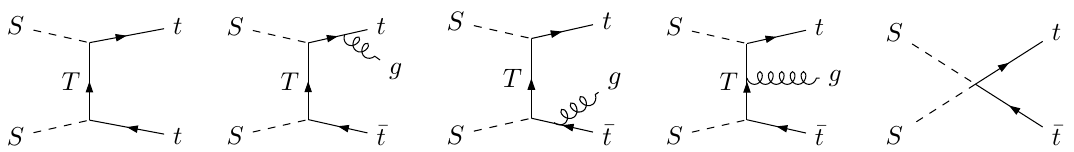
Figure 1 . Representative Feynman diagrams of processes which contribute to the annihilation cross section of top-philic DM. Illustrative LO (left-most), QCD NLO (middle) and contact term (right) contributions are displayed, where the second and third diagrams are referred to as final state radiation (FSR) and the fourth diagram is virtual internal bremsstrahlung (VIB). complement the SM with the